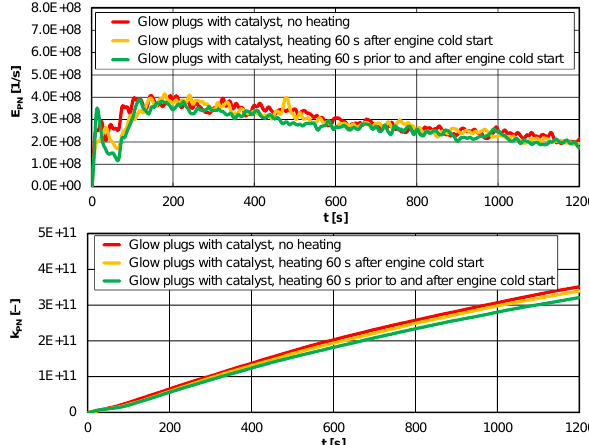
Fig. 5. Particle number intensity and particle number during the tests performed on a diesel engine depending on the catalyst-coated glow plug heating time When analyzing the concentration of carbon dioxide